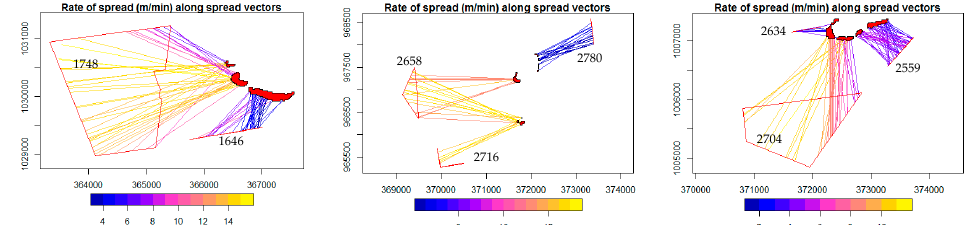
Figure 2. Rate ‐ of ‐ spread vectors color coded by ROS (m/min) for the S ‐ 2 observations in Figure 1. Red filled polygons correspond to S ‐ 2 fire detections, red outlined polygons correspond to the concave hull shapes constructed from the VIIRS fire detection pixel center points. The images may have VIIRS fire detection envelopes from different overpasses (associated with NOAA 20 and S ‐ NPP satellites) and hence spread vectors of similar length may have different associated ROS measures. The numbers on or near the VIIRS fire detection envelopes correspond to the associated boxplots in Figure 7.